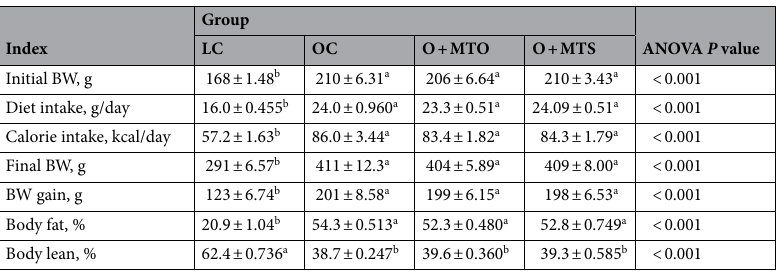
Table 3. Diet intake, body weight and body composition of lean and obese Zucker rats fed a diet containing milk thistle seed oil (+ MTO) or milk thistle seeds (+ MTS) for 5 weeks. Values are means ± SEMs, n = 7–8. Labeled means in a row without a common letter (a,b) differ at P ≤ 0.05 (Duncan’s or Dunn’s post hoc test). BW body weight, LC lean control, OC obese control, O + MTO obese fed a diet containing milk thistle seed oil, O + MTS obese fed a diet containing milk thistle